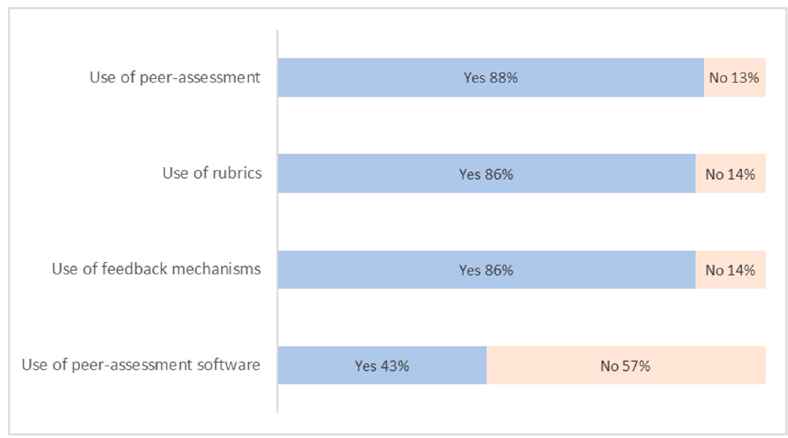
Figure 12. Comparison of the use of peer assessment, rubrics, feedback mechanisms, and peer assessment software among respondents.